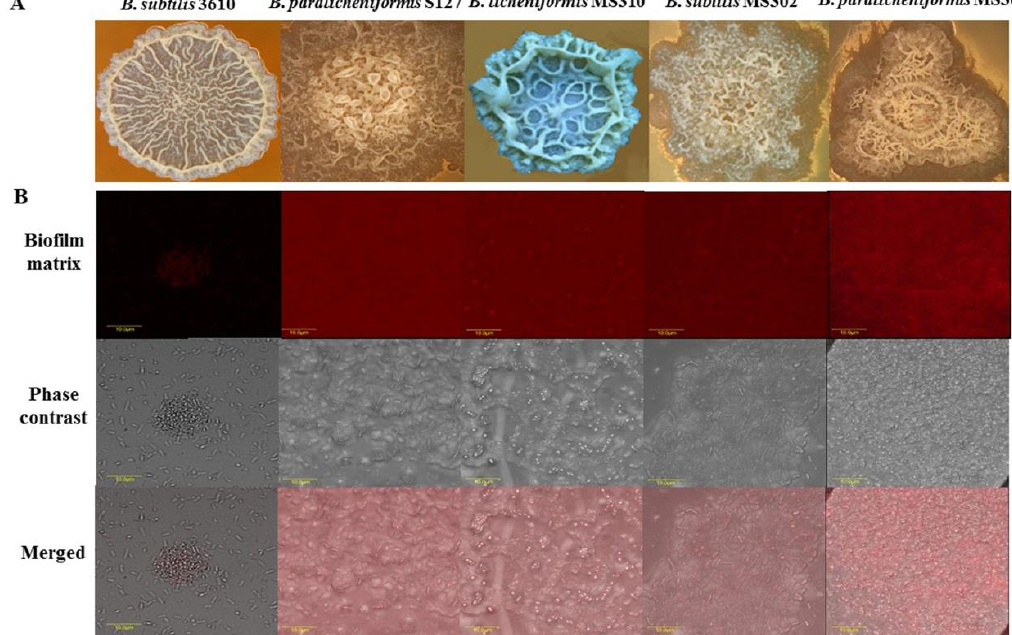
Figure 1. Dairy-associated Bacillus isolates exhibit robust biofilm formation. ( A ) Colony type biofilm formation by the tested Bacillus strains in the biofilm-promoting medium, LBGM. The images were taken using a stereoscopic microscope (Zeiss Stemi 2000-C; Carl Zeiss, Gottingen, Germany). ( B ) Biofilm-derived spores of the dairy Bacillus strains are surrounded by high amounts of the extracellular matrix. Protein components of the biofilm matrix were stained red. The samples were analyzed using a confocal laser scanning microscope (CSLM, Olympus, Japan). Scale: 10 µ